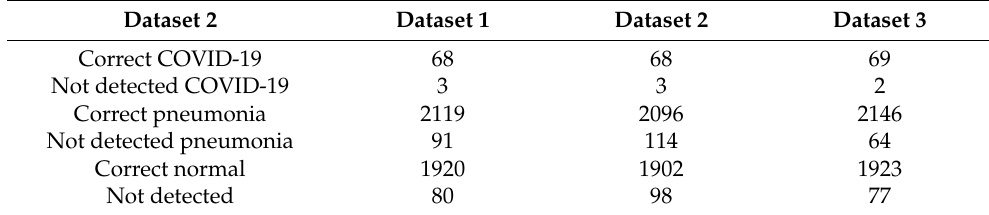
Table 4. PSO results of all datasets.